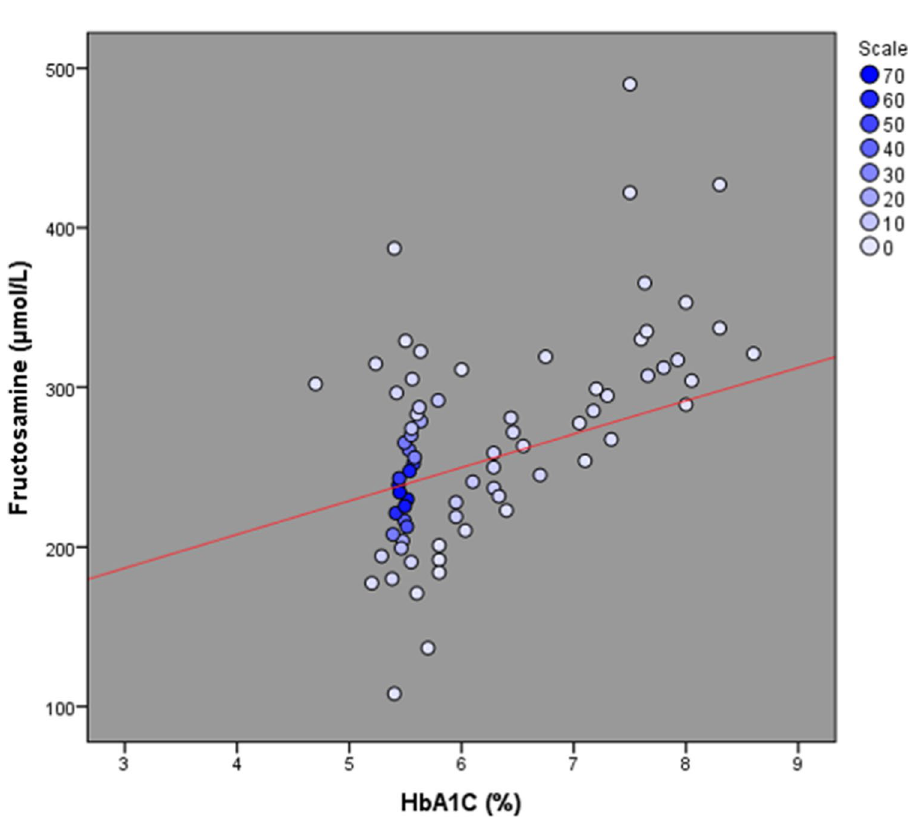
Figure 3. A scatter plot correlating HbA1c and fructosamine (R 2 =